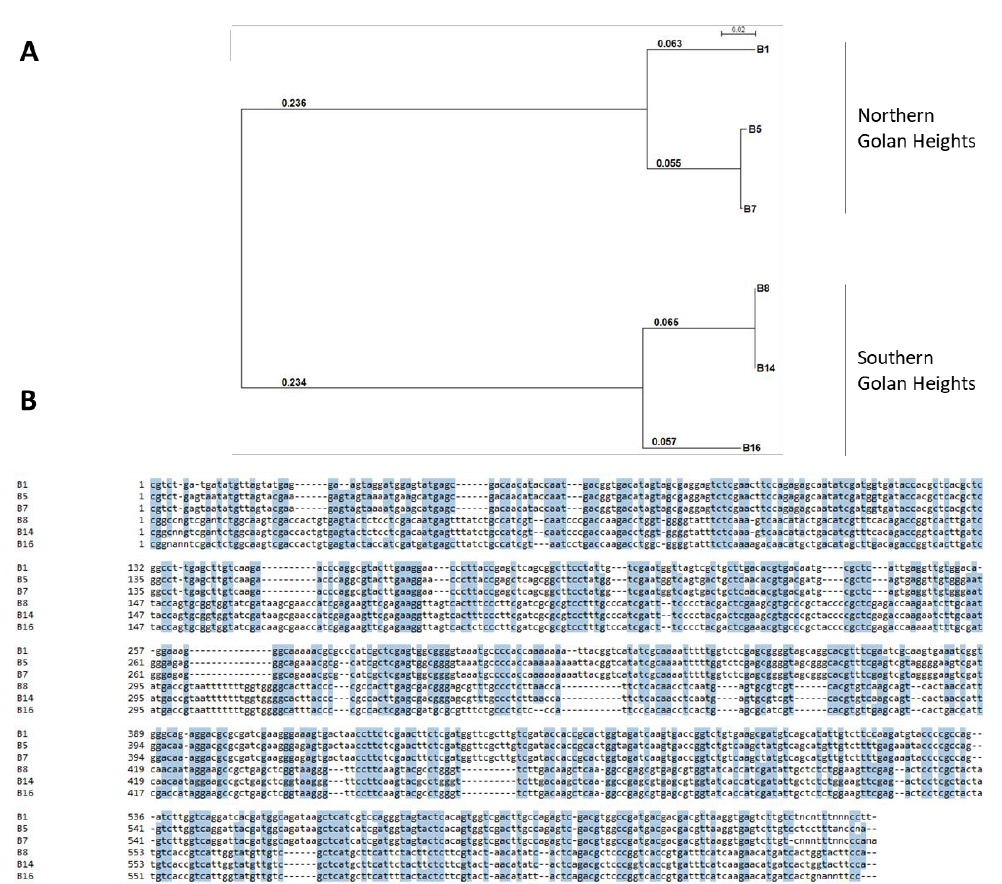
Figure 6. Phylogenetic analysis of the Fusarium isolates. Phylogenic relationships of the TEF1 gene and the six Fusarium isolates (presented in Table 2). The scale in the upper part refers to the genetic similarity of the isolates. Sequences were aligned using the Clone Manager 10.0 program (Sci Ed Software, Durham, NC, USA). The SeaView version 5.0 program (http://doua.prabi.fr/software/seaview) was used to generate a phylogenetic tree. The alignment was performed using bootstrap with 1000 replicates and excluded positions with gaps.